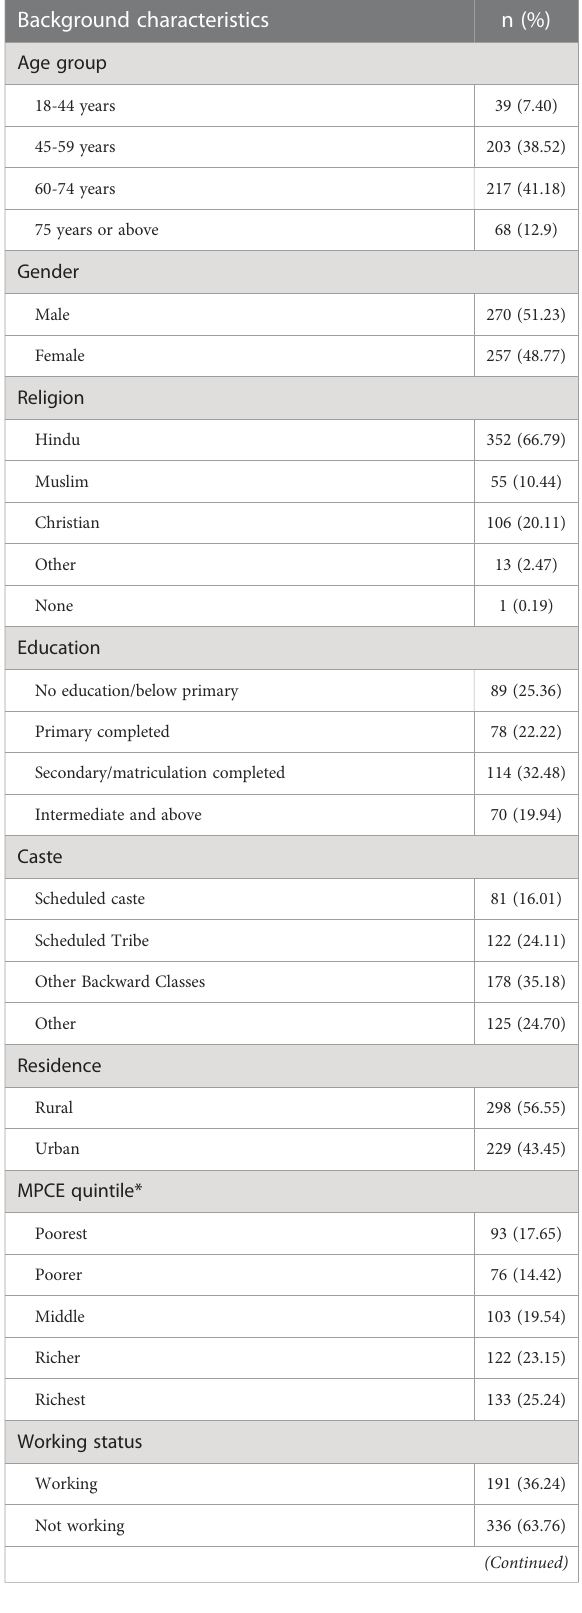
TABLE 1 Background characteristics of chronic kidney disease patients. Background